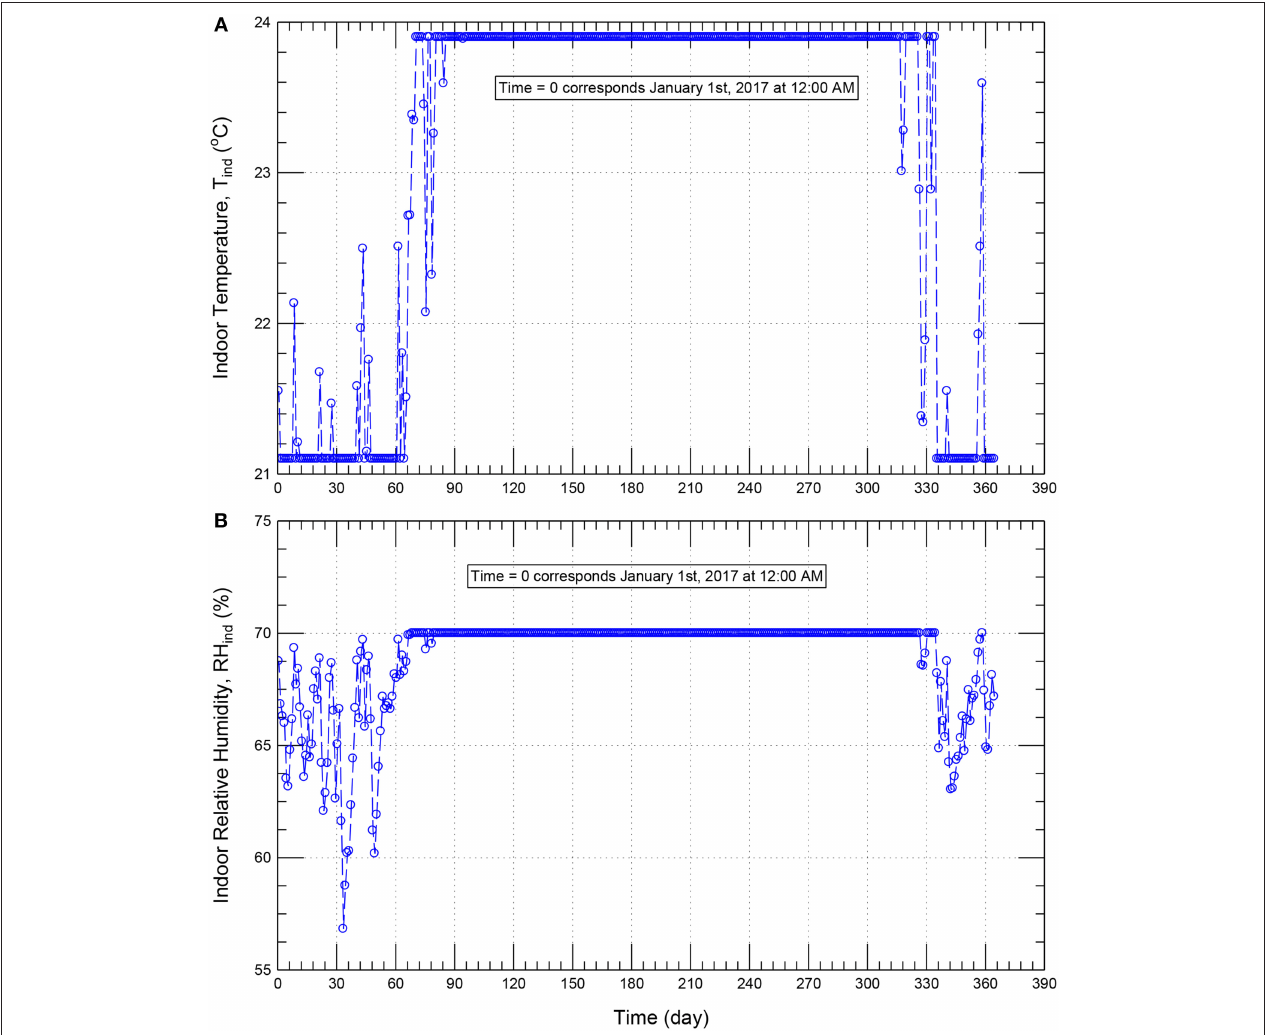
FIGURE 4 | Indoor conditions for temperature (A) and relative humidity (B) based on ASHREAE 160—simple method (ASHRAE, 2009) for the climatic conditions of the Eastern Province of Saudi Arabia.